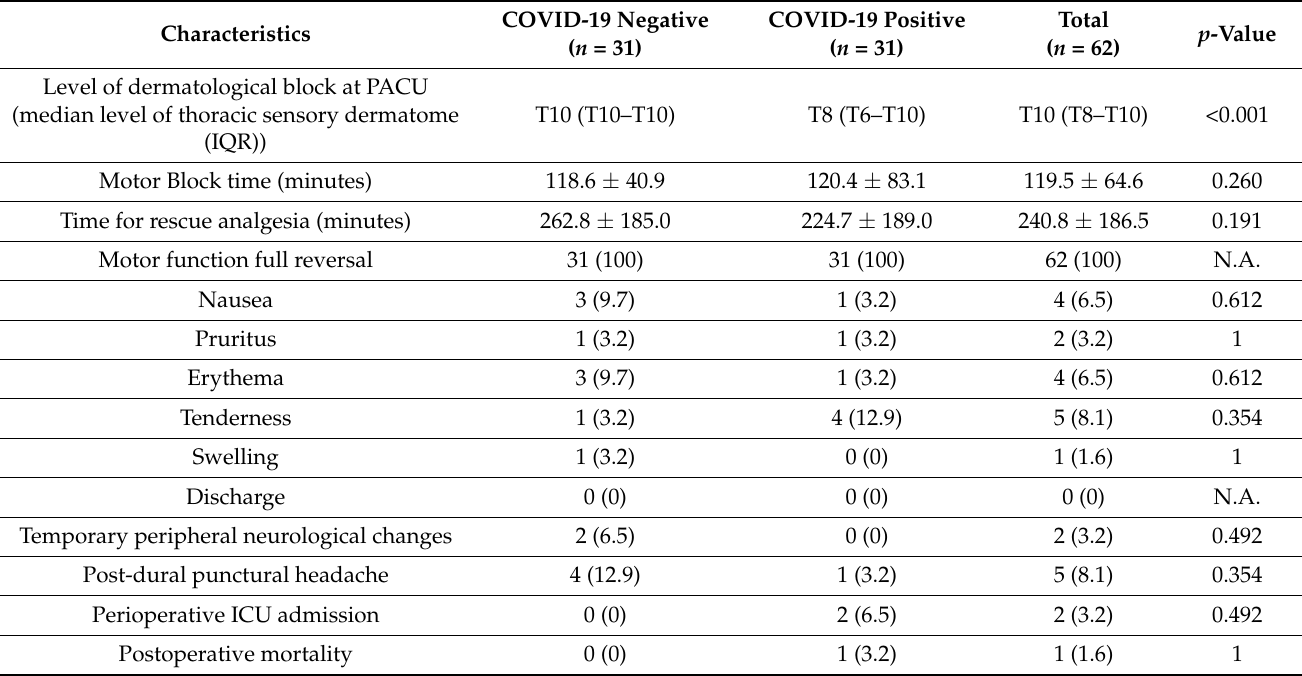
Table 6. Postoperative follow-up at the post anesthesia care unit and during the in-hospital stay.